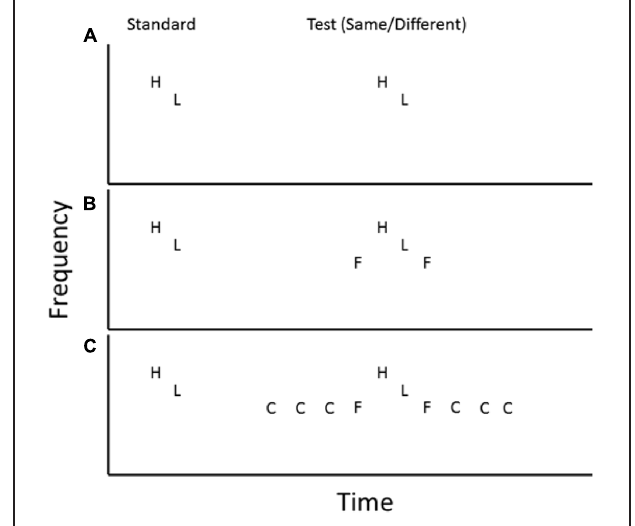
C, captor tone. Order of H and L tones may be either the same or different on both occasions. Panel (A) indicates condition where target test tones are presented on their own, panel (B) indicates the addition of flanker tones immediately before and after target test tones, and panel (C) indicates the further addition of captor tones preceding and following the flanker